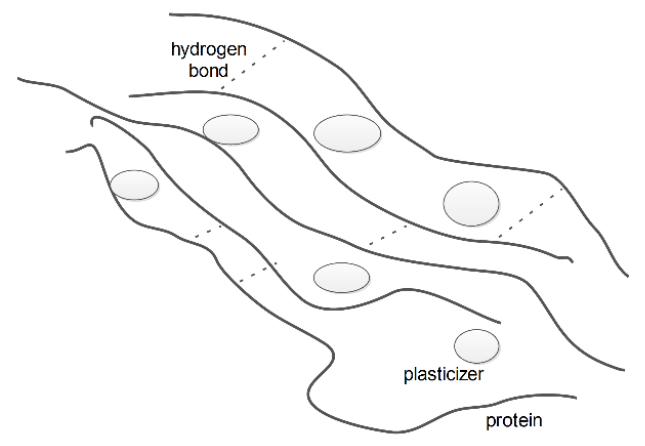
Figure 7. Activity of plasticizer between protein chains.